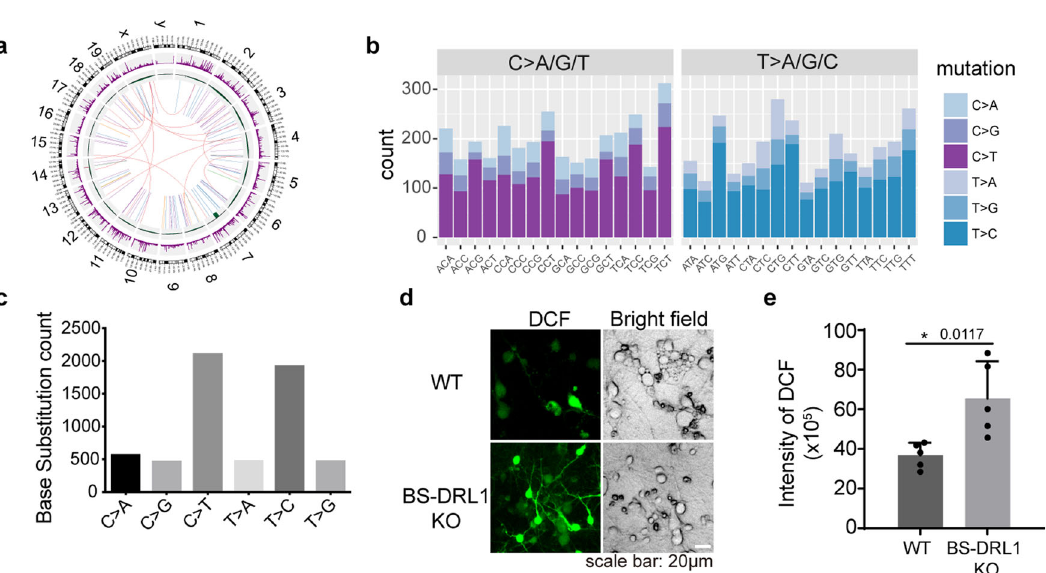
Fig. 3 BS-DRL1 KO mice show genome instability. a Circos plot of 3-month-old mice from the whole-genome sequencing data of 3 pairs of BS-DRL1 KO mice brain tissues. The circle plot represents rearrangements (inner arcs), copy-number alternations (inner rings) and single nucleotide polymorphisms (middle rings). In rearrangements, lines show translocation breakend (red), deletions (blue), tandem duplication (green), insertions (purple), inversions (orange). Copy-number gain and loss regions are shown in red and green. b , c Summary of the base substitute in mutations identi fi ed by whole-genome sequencing of three pairs of BS-DRL1 KO mice brain tissues. d , e ROS level of primary neurons (DIV9) from BS-DRL1 KO mice and littermate controls were measured with an oxidation-sensitive fl uorescent probe DCFH-DA (Dichloro-dihydro- fl uorescein diacetate). Five images were used for statistics, Data are presented as mean ± SD, * p <